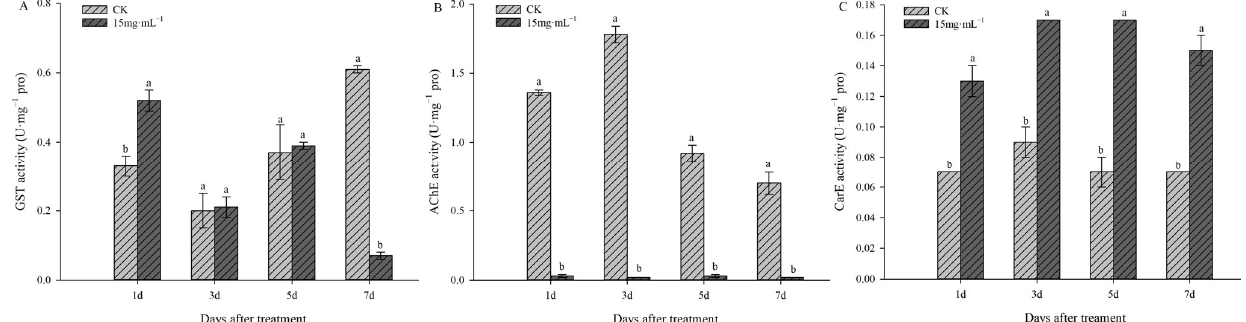
Figure 3. The impact of 15 mg ∙ mL − 1 GSE on glutathione S ‐ transferase (GST) activity ( A ), acetylcho ‐ linesterase (AChE) activity ( B ), and carboxylesterase (CarE) activity ( C ) of M. sorghi across succes ‐ sive treatments. CK, 10% ethanol. Data are mean ± SE. Different letters (a, b) for the same time in each figure indicate significant differences ( α = 0.05).